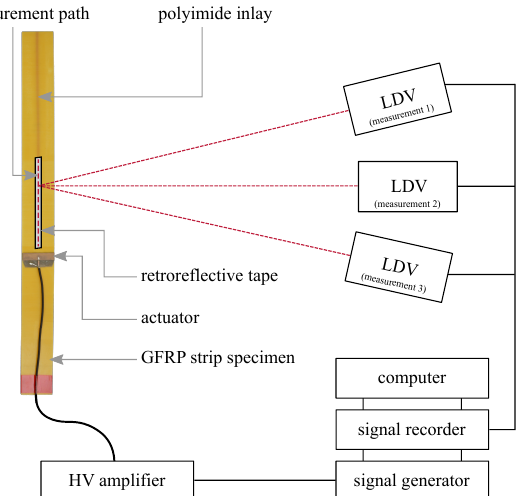
Figure 7. Experimental setup of 3D laser Doppler vibrometry measurement to separately deter- mine in-plane and out-of-plane components of wave propagation after performing a coordinate transformation according to [45]. Figure adapted from